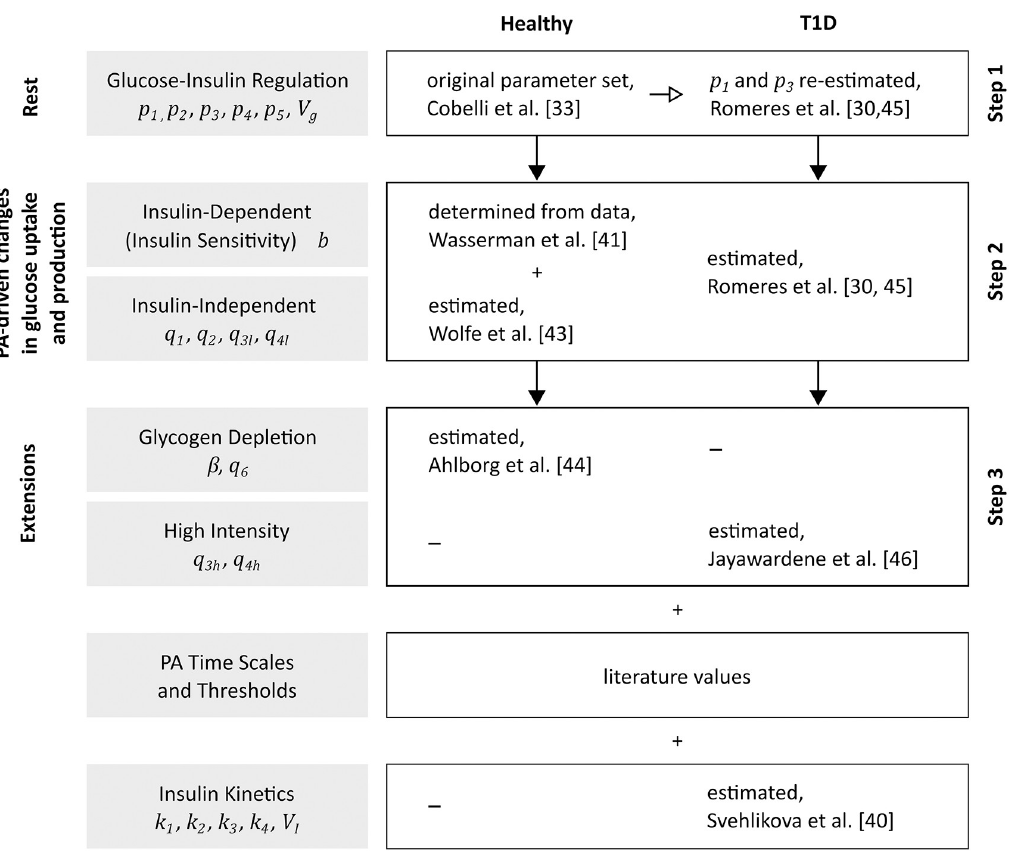
Fig 2. Model calibration. Schematic of the stepwise calibration process for healthy individuals and people with T1D.